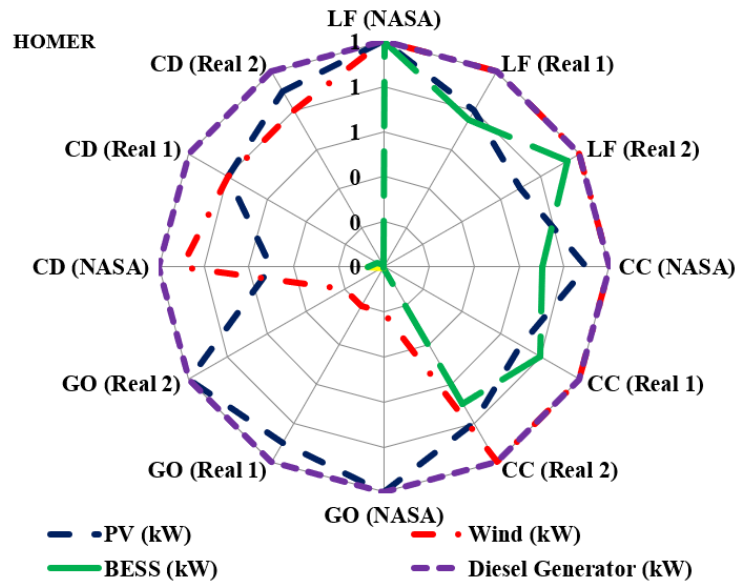
Figure 5. Comparison of optimal capacity (normalized) of generation and storage for three datasets according to four dispatch strategies in HOMER Pro.